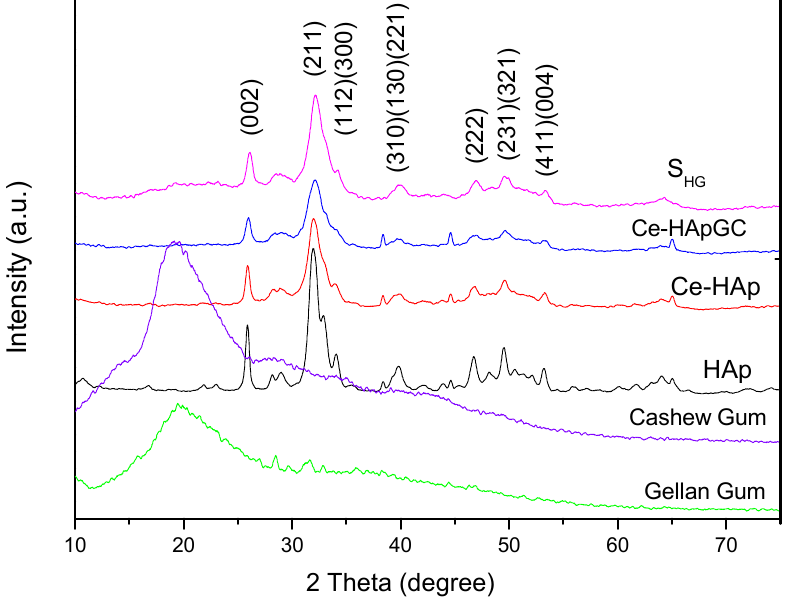
Figure 2. X-Ray diffractograms (XRD) patterns of powders hydroxyapatite (HAp), cerium (Ce)-HAp, Ce-HAp cashew gum (CG), the scaffold based on Ce-HApCG+gellan gum (GG) (S HG ), cashew gum, and gellan gum.